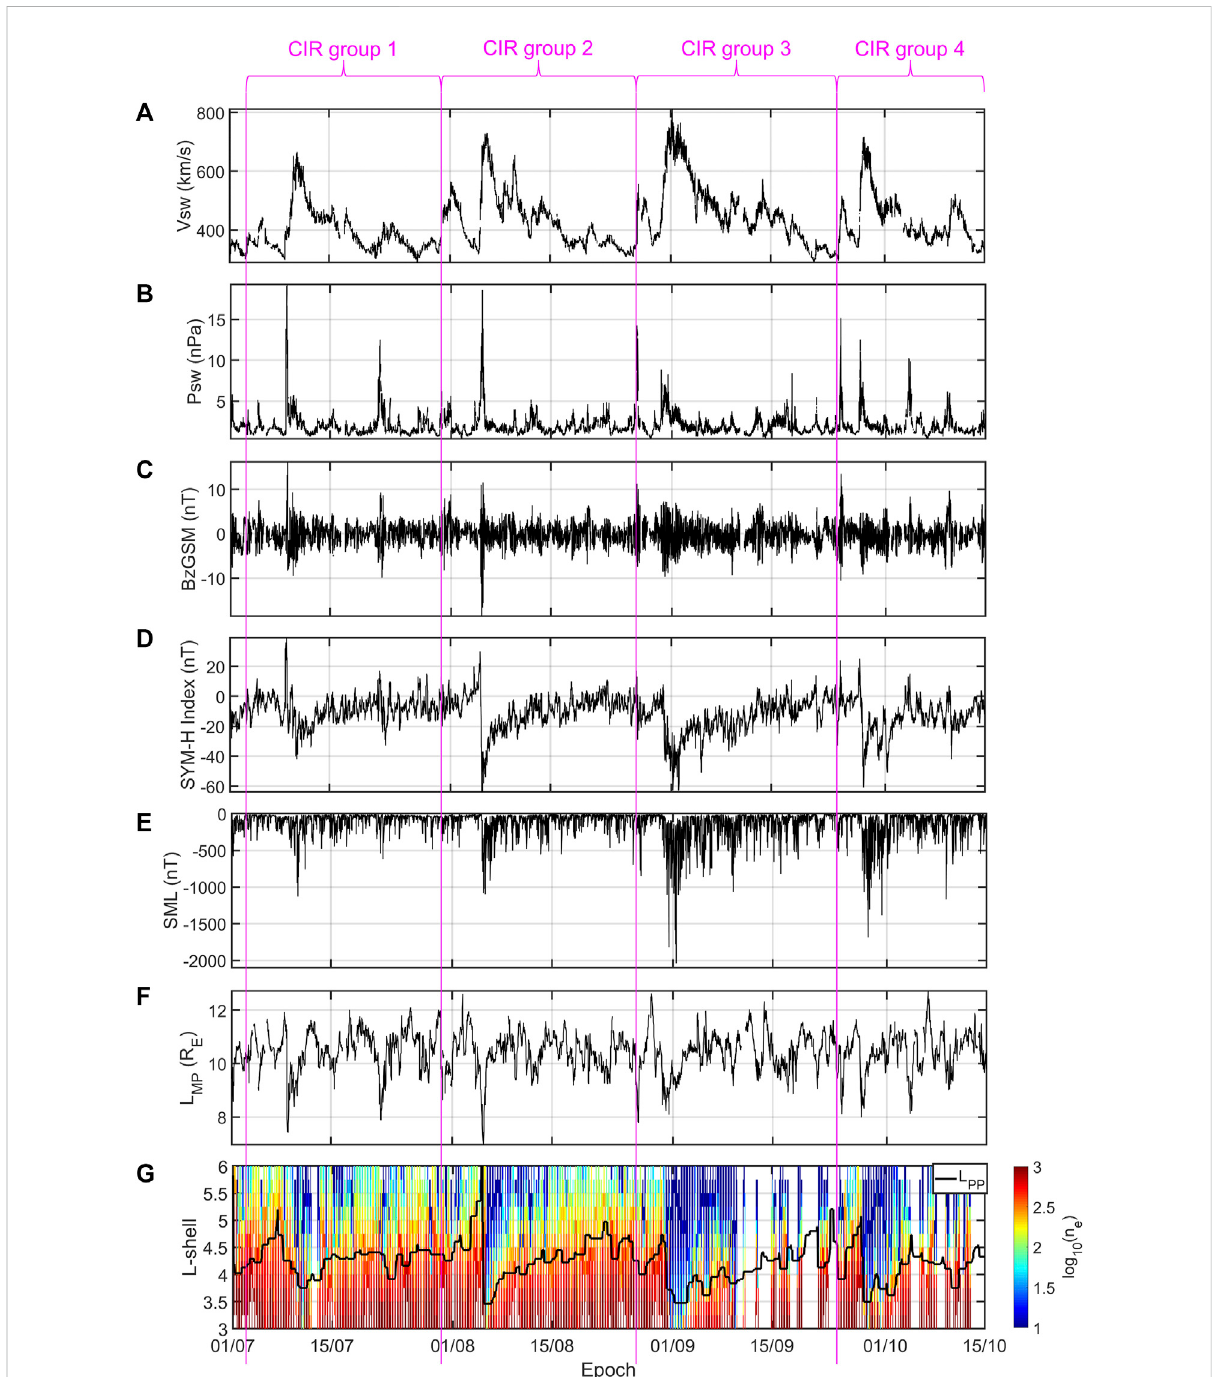
FIGURE 1 (A) ThesolarwindvelocityVsw(km/s), (B) thesolarwinddynamicpressurePsw(nPa), (C) thesouthwardcomponentBz(nT)oftheinterplanetary magnetic fi eld, and (D) the geomagnetic index SYM-H (nT), all plotted using data form the OMNIWeb database. (E) The SML auroral electrojet index (nT; data from the SuperMAG database), (F) the location of the dayside magnetopause L MP (R E ; calculated following the model of Shue et al. (1998), using data from the OMNIWeb database) and (G) the MLT-averaged location of the plasmapause L PP (R E ; black line; calculated following the model of O ’ Brien & Moldwin (2003), using data from the OMNIWeb database) plotted over the logarithm of the electron density n e (cm − 3 ; colored plot;calculatedfollowingKurthetal.(2015),usingdatafromtheEMFISISdatabase;binnedfordT=3 h,dL=0.25R E ).Allplotscorrespondtothetime period of 1/7/2019 to